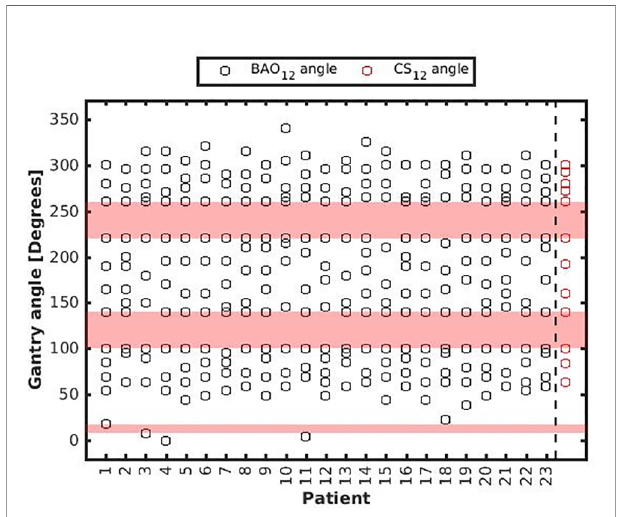
FIGURE 5 | Patient-speci fi c BAO 12 beam angles. As a reference, CS 12 beam angles were added with red markers in the last column, see also Table 1 . BAAs are depicted in pink.